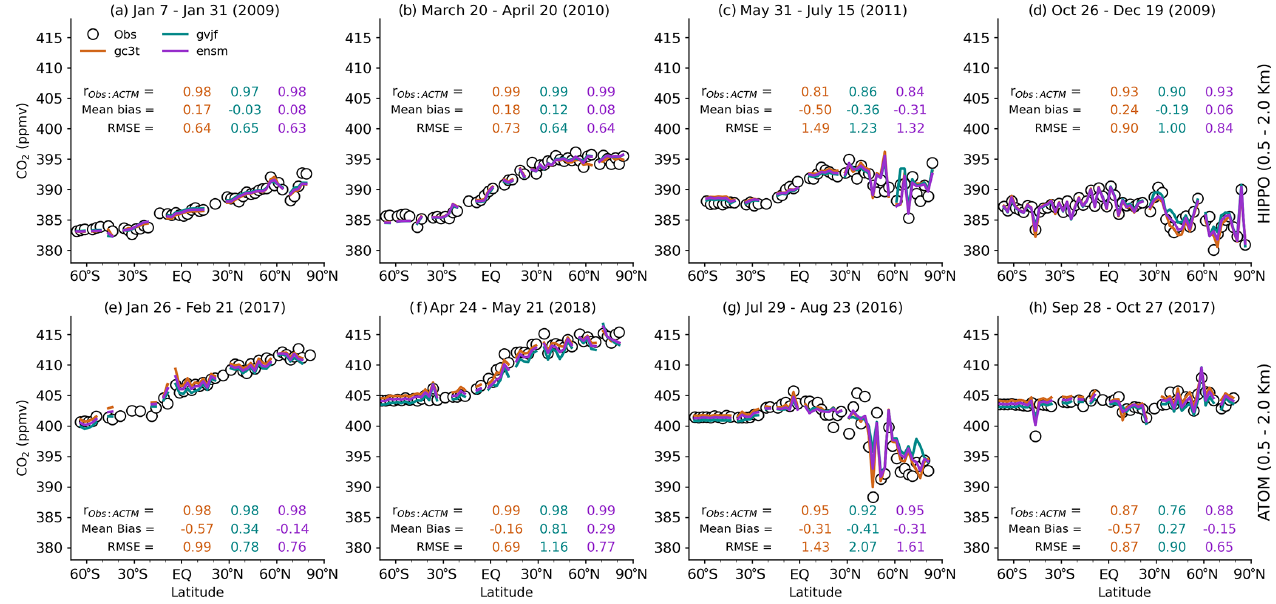
Figure 11. Observed and modeled meridional CO 2 distribution during HIPPO and ATom campaigns. We aggregate the observed and sim- ulated mole fractions for the lower troposphere (between 0.5 and 2.0km) at 2.5 ◦ latitudinal bins. The correlation coefficient, mean model– observation bias, and root-mean-square error (RMSE) are also shown in each